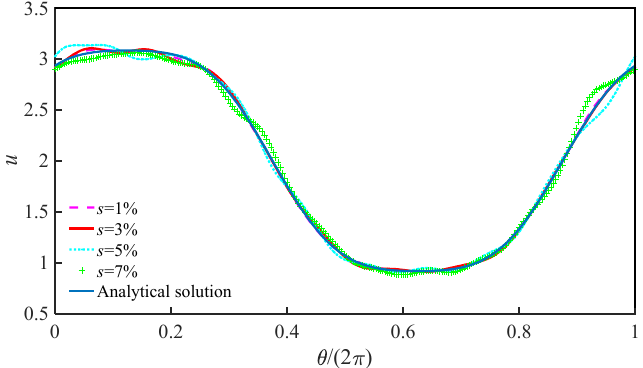
Γ . Figure 8. Comparisons between the numerical and analytical solutions on Γ 2 .